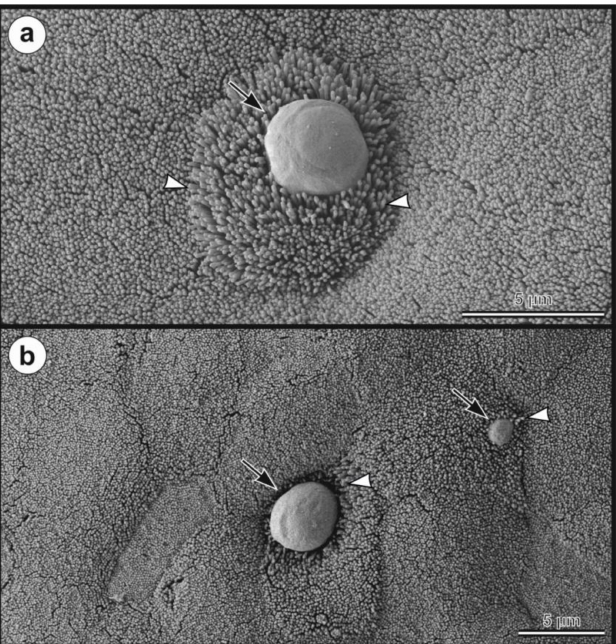
Figure 8. Scanning electron microphotograph showing developmental stages of Cryptosporidium myocastoris n. sp. (arrow) on ( a ) jejunal and ( b ) ileal mucosal epithelium in experimentally infected adult nutria ( Myocastor coypu ) which was sacrificed 10 days post infection. Elongation of the microvilli around attached developmental stage (arrowhead). Scale bar included in each